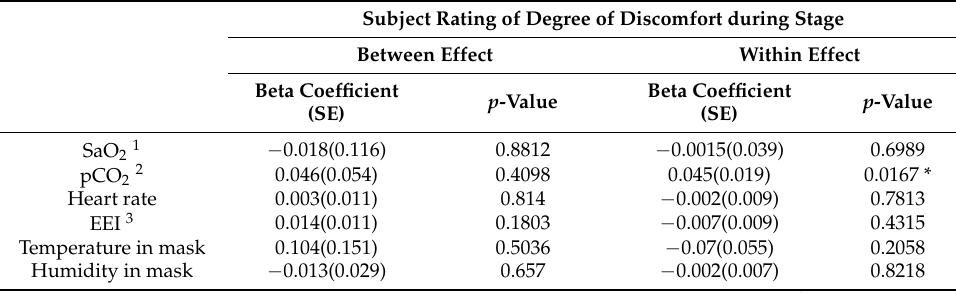
Table 3. Correlations between physiologic parameters and subjective discomfort ratings.